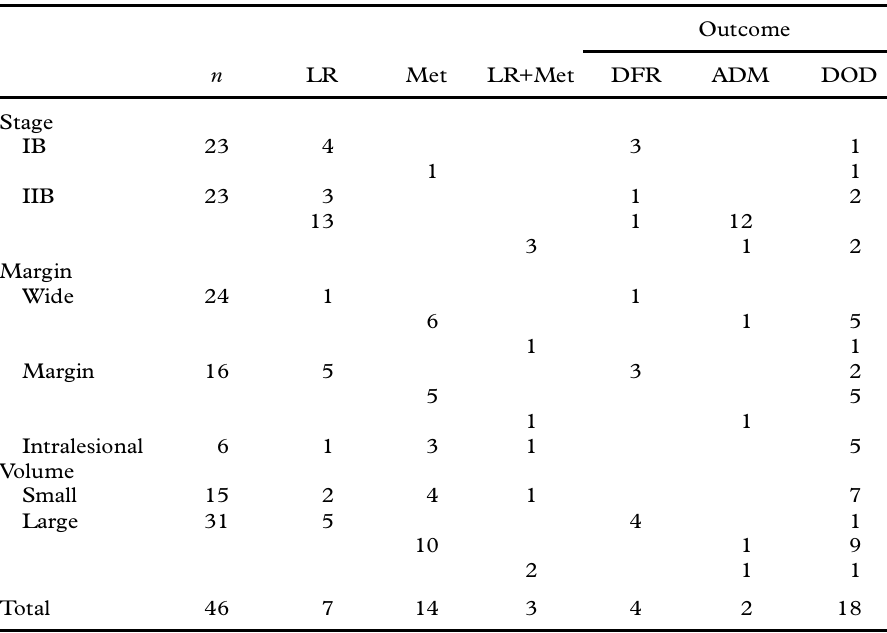
Table 5. Occurrence of local recurrence (LR) and metastases (Met) in relation to tumor stage and surgical margin achieved (stage III and IA tumors were